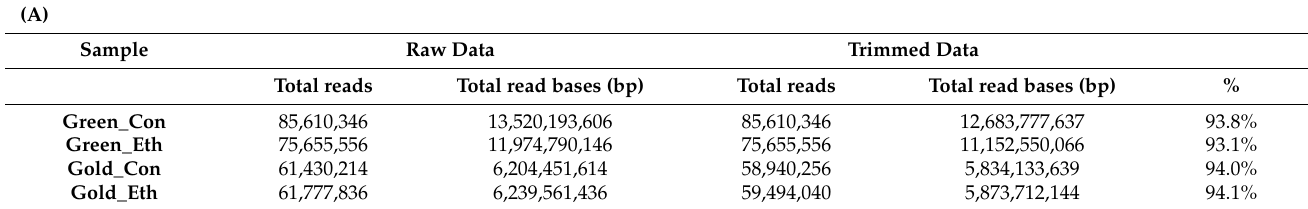
Table 1. Summary of raw and trimmed data (A) and mapping rate (B) and differentially expressed genes (DEGs) during the comparison of control vs. ethylene-treated green ‘Hayward’ and gold ‘Haegeum’ kiwifruit cultivars